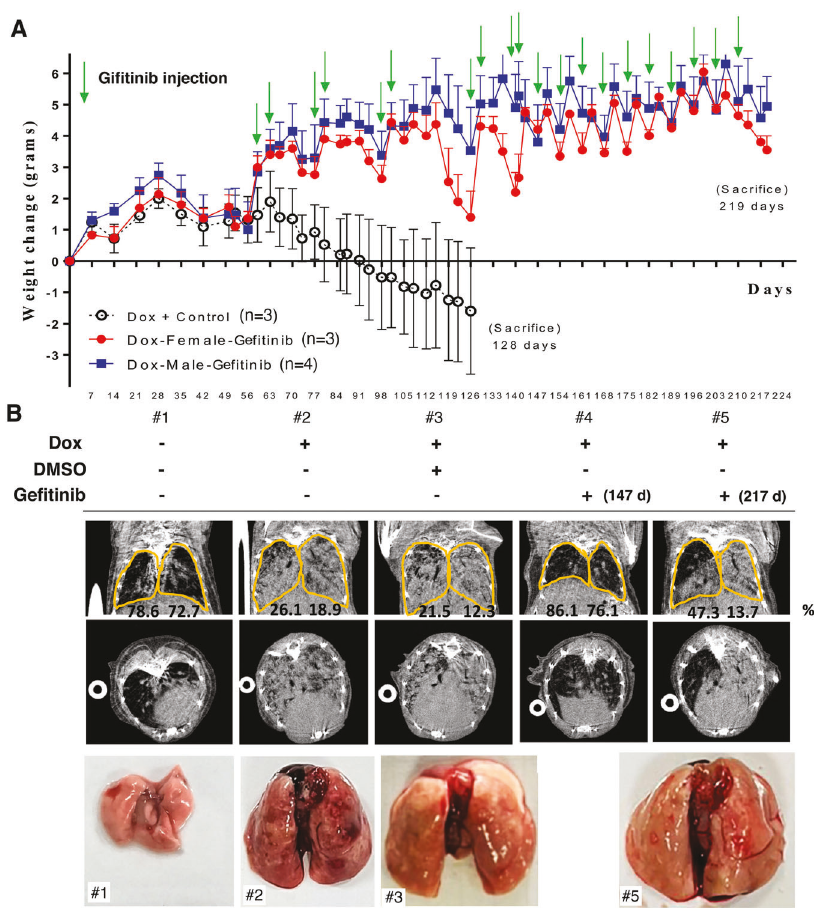
Fig. 1 An animal model of TKI-induced drug resistance was established. Lung tumors were induced in EGFR L858R mice by doxycycline (0.5 g/l in drinking water) treatment for 7 weeks, followed by treatment with 20 mg/kg ge fi tinib including Dox + Control ( n = 3), Dox-Female-Ge fi tinib ( n = 3) and Dox-Male-Ge fi tinib ( n = 4) until drug resistance was observed, and all the mouse body weight was measured every week ( A ). In vivo tumor growth was monitored by micro-CT at different times until the establishment of drug resistance (217th day) and quantitated the air space by Sigma J software, then, the mice were sacri fi ced, and the lungs are shown here ( B